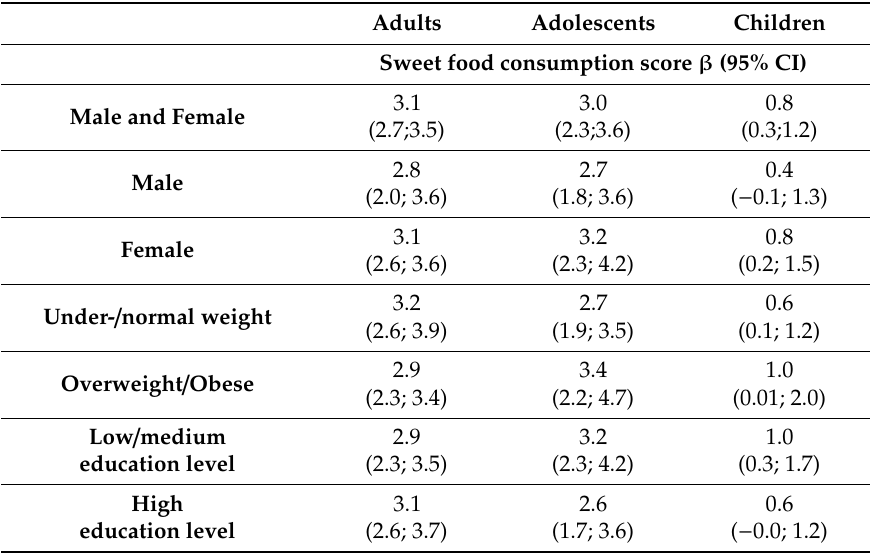
Table 4. Stratified results of the association between sweet and fatty taste preference and sweet and fatty food propensity scores ( β estimates and 95%